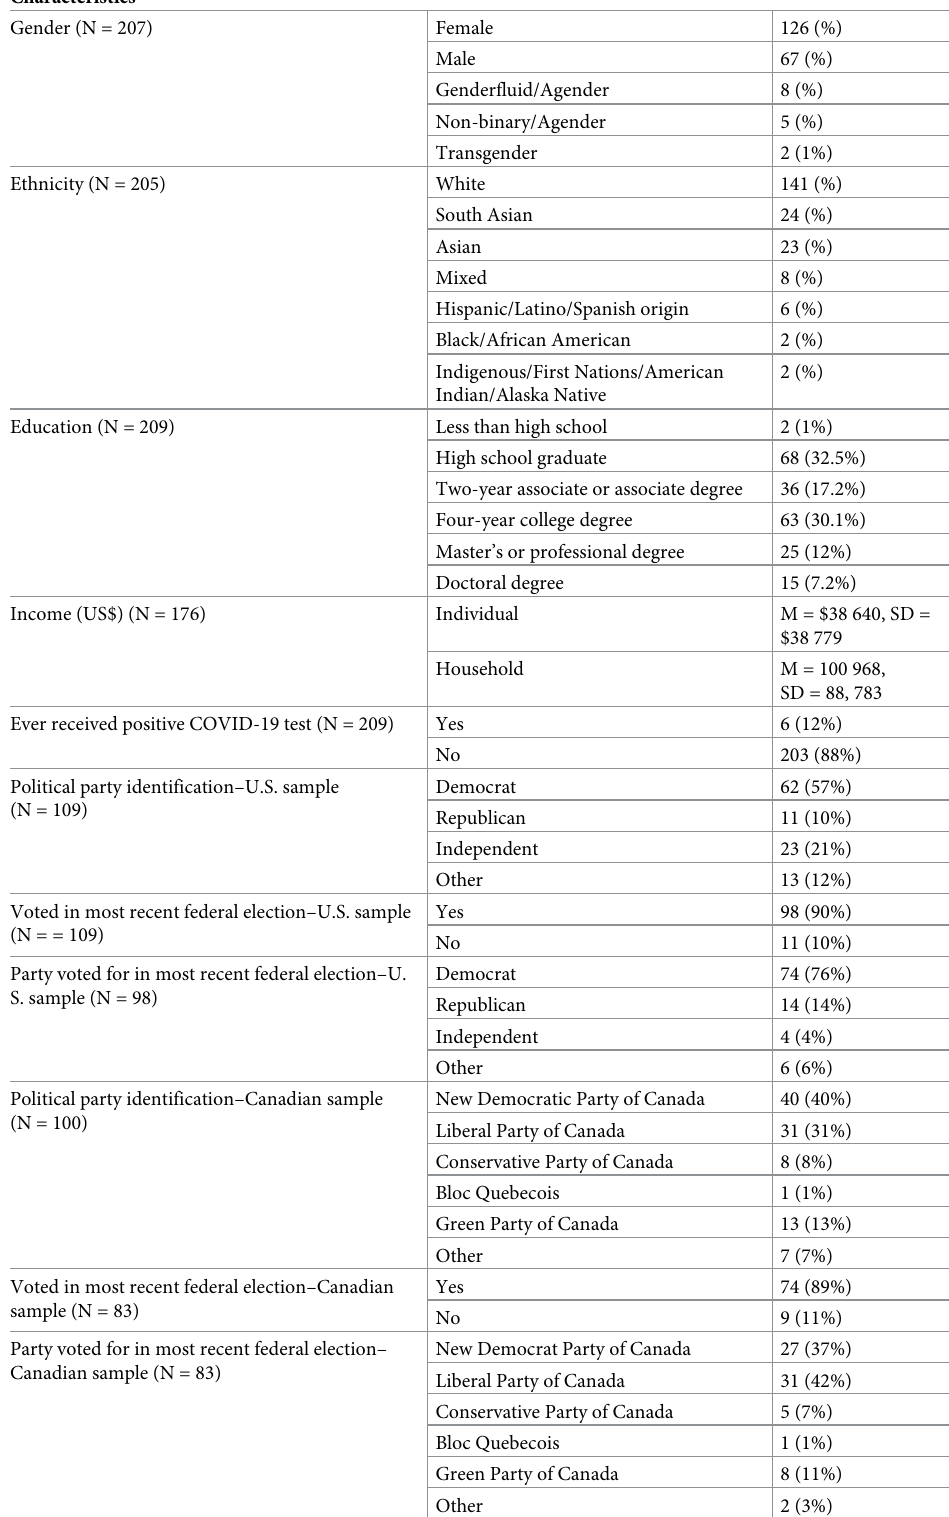
Table 1. Descriptive statistics for demographic and descriptive political